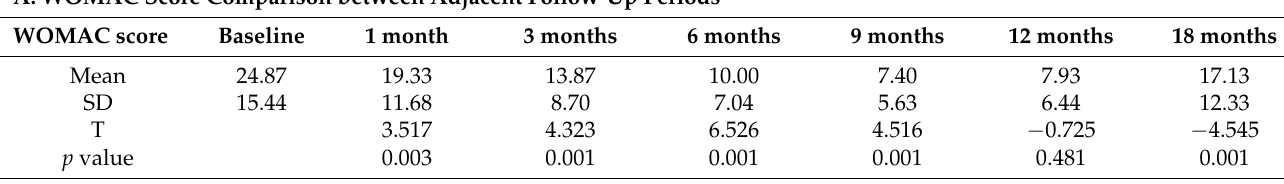
Table 2. Changes in knee joint function outcomes during